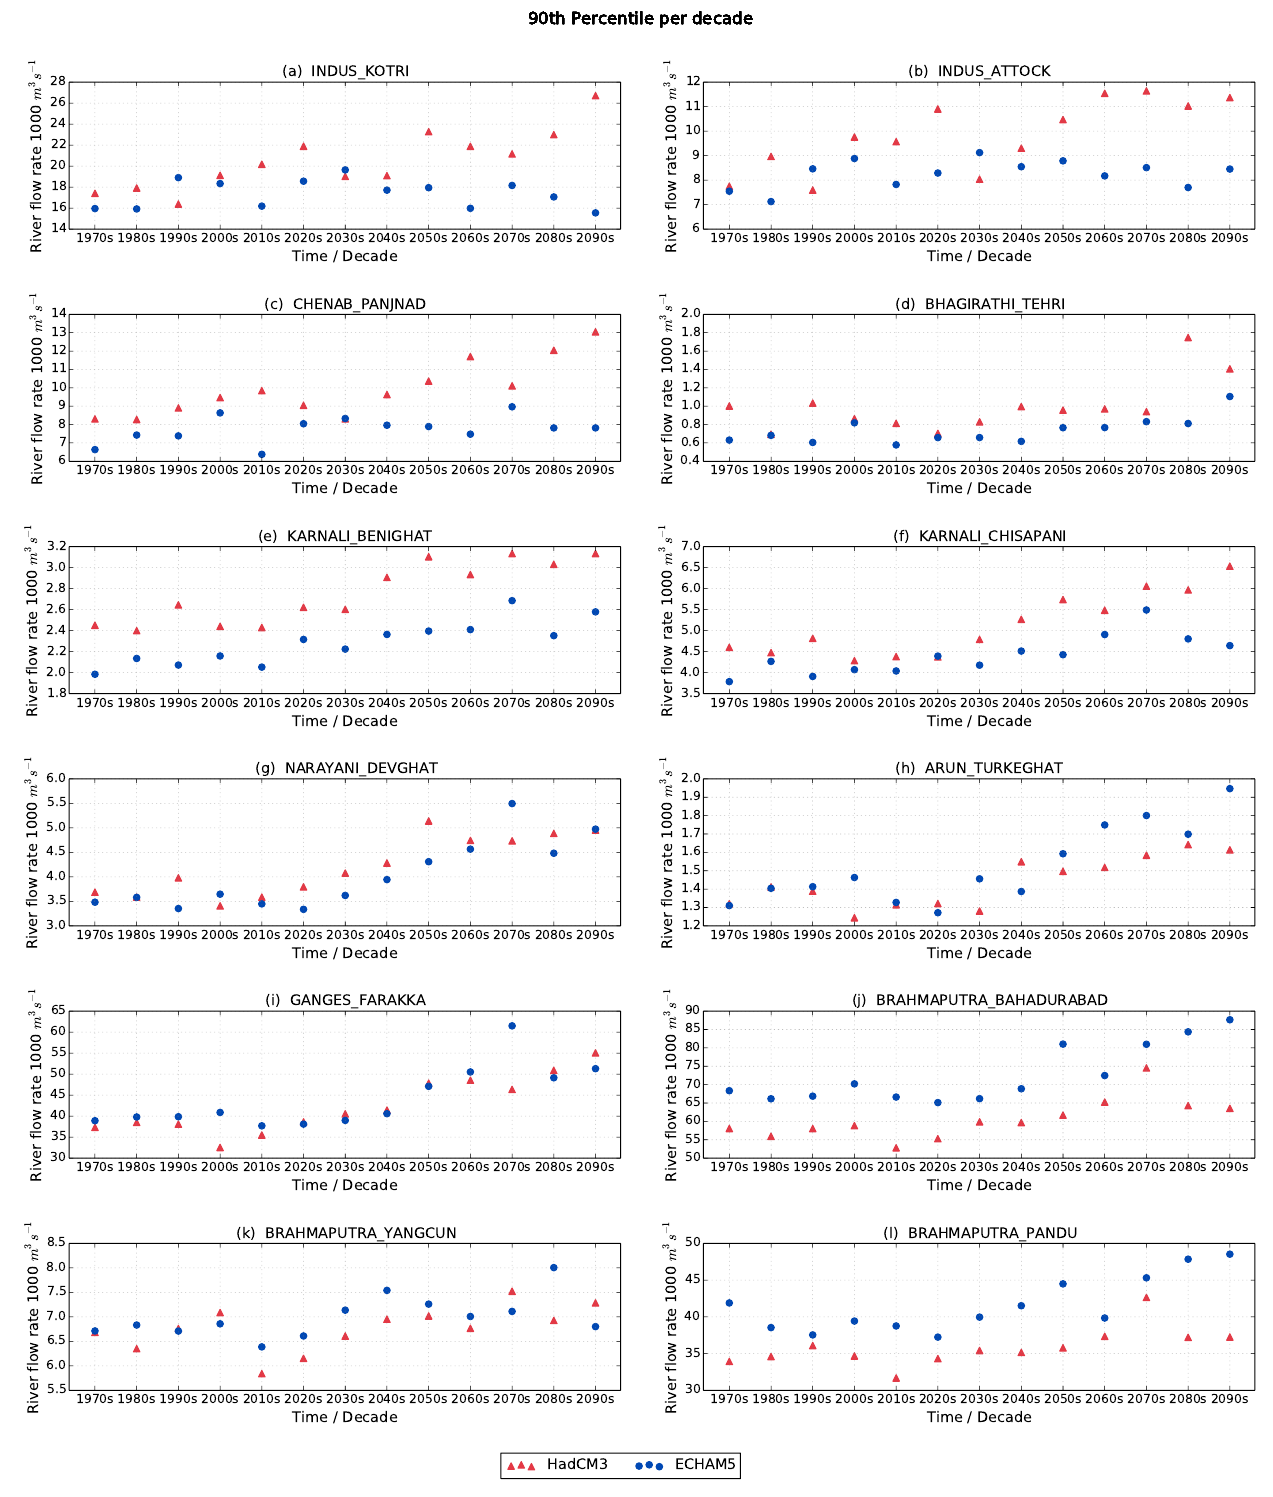
Figure 14. The 90th percentile of river flow for each decade for HadCM3 (red triangles) and ECHAM5 (blue circles) for each river gauge.